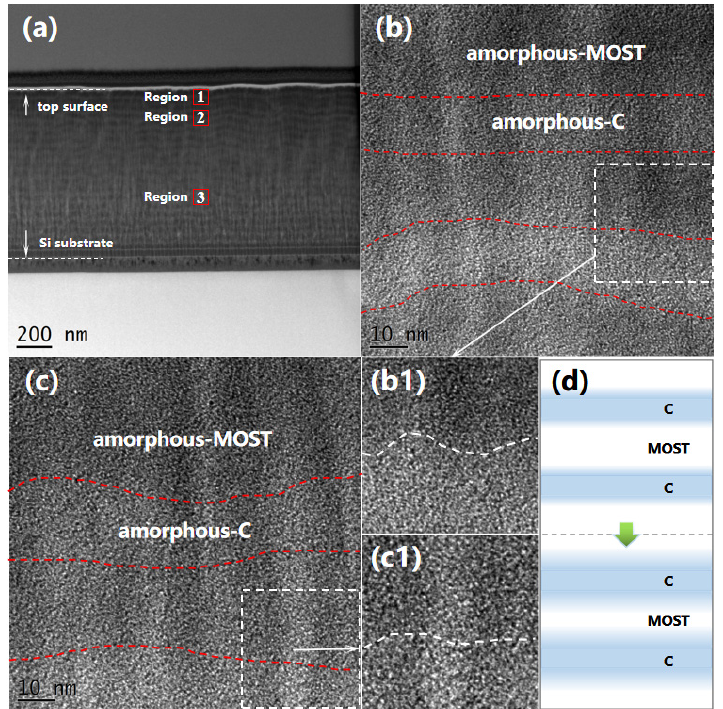
Figure 4. Cross-section TEM image ( a ) and local magnification image of the irradiated film: region 1-( b , b1 ); region 2-( c , c1 ); ( d ) corresponds to a simplified graph of ( b , c ).